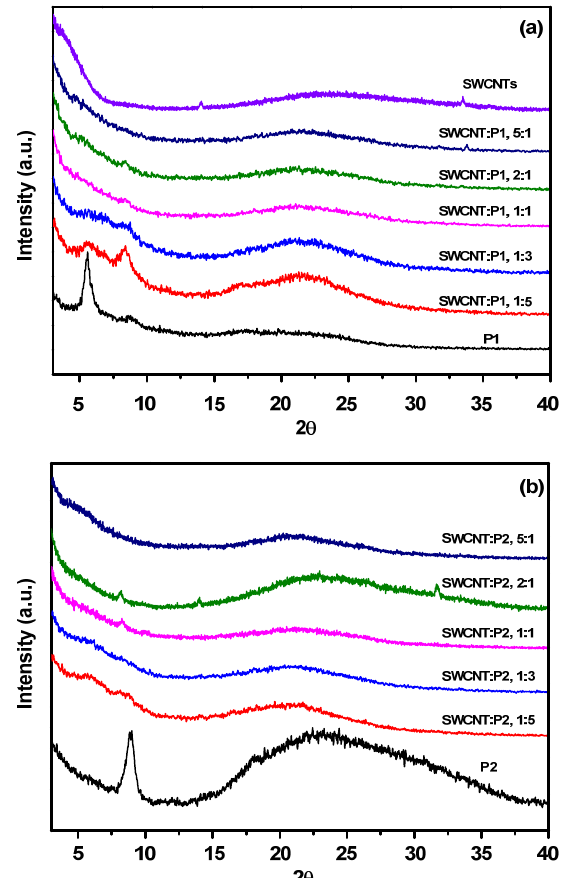
Figure 5. Grazing incidence X-ray diffraction (GI-XRD) spectra of the ( a ) pristine P1 and its SWCNT composites and ( b ) pristine P2 and its SWCNT composites.